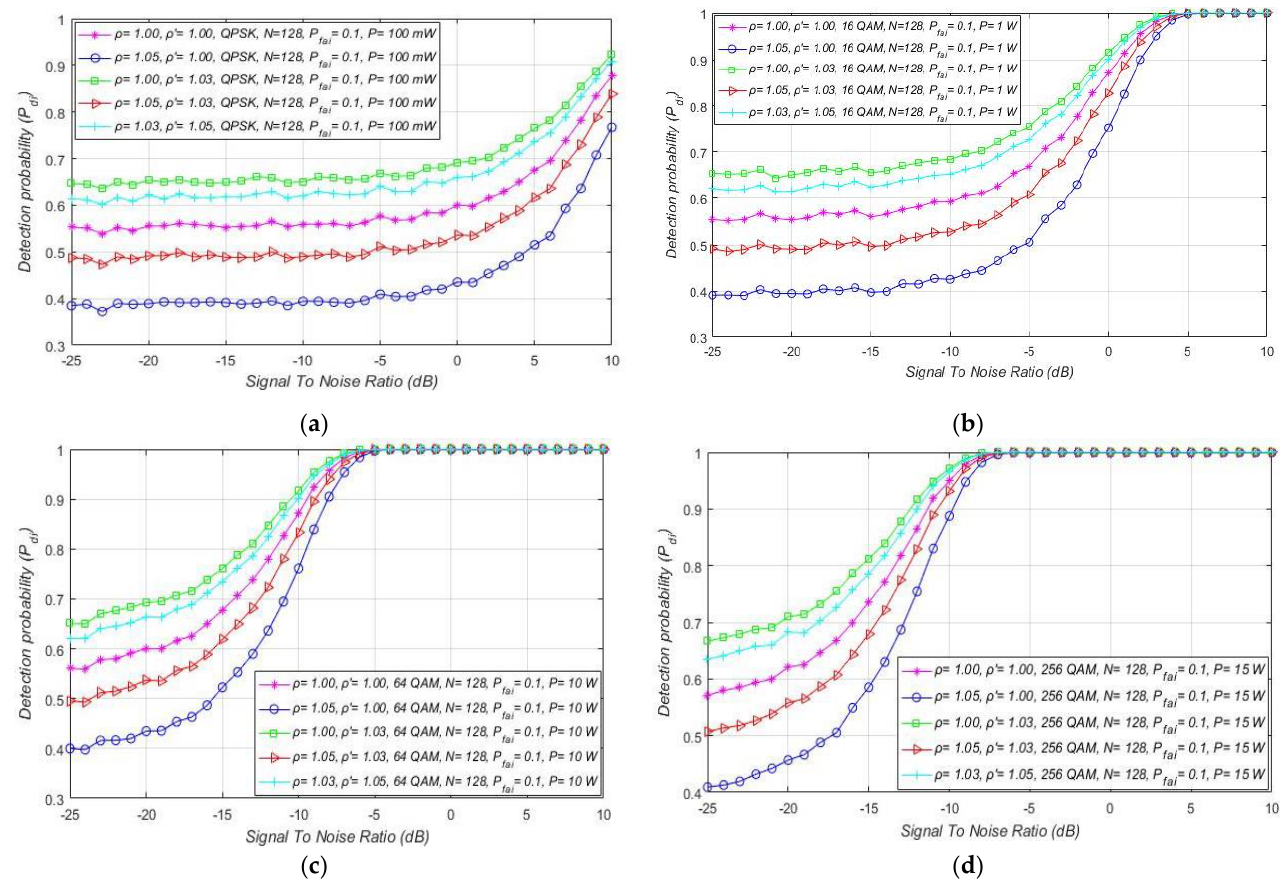
Figure 10. Impact of SNR on the detection probability of OFDM signals received under versatile combinations of NU and DT factors when PU transmits at: ( a ) 0.1 W; ( b ) 1 W; ( c ) 10 W and ( d ) 15 W.